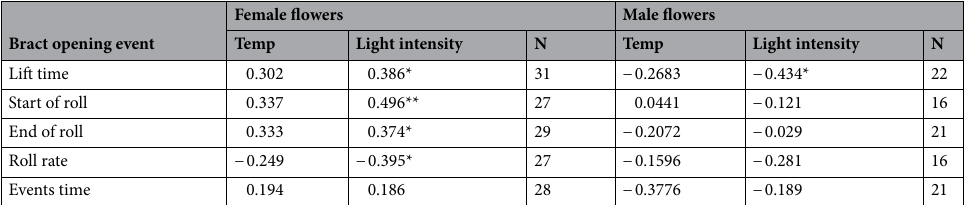
Table 3. Correlation coefficients between weather attributes and bract opening time in banana at the IITA— Sendusu station. * P < 0.05, ** P < 0.01, Daily average light intensity (lux), Temp—Daily average temperature (°C), and N—number of